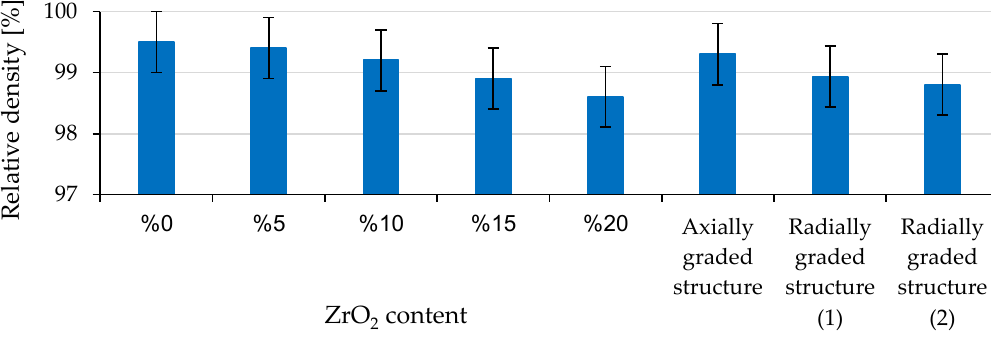
Figure 7. Maximum achieved relative densities of each specimen and layer after the powder forging process.